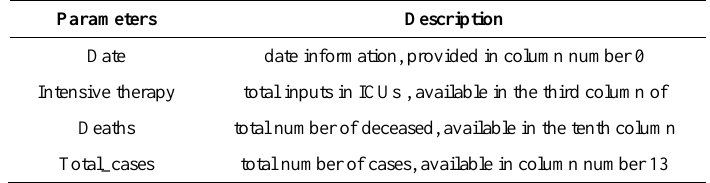
Table 4. Description of the parameters extrapolated from the Civil Protection Github